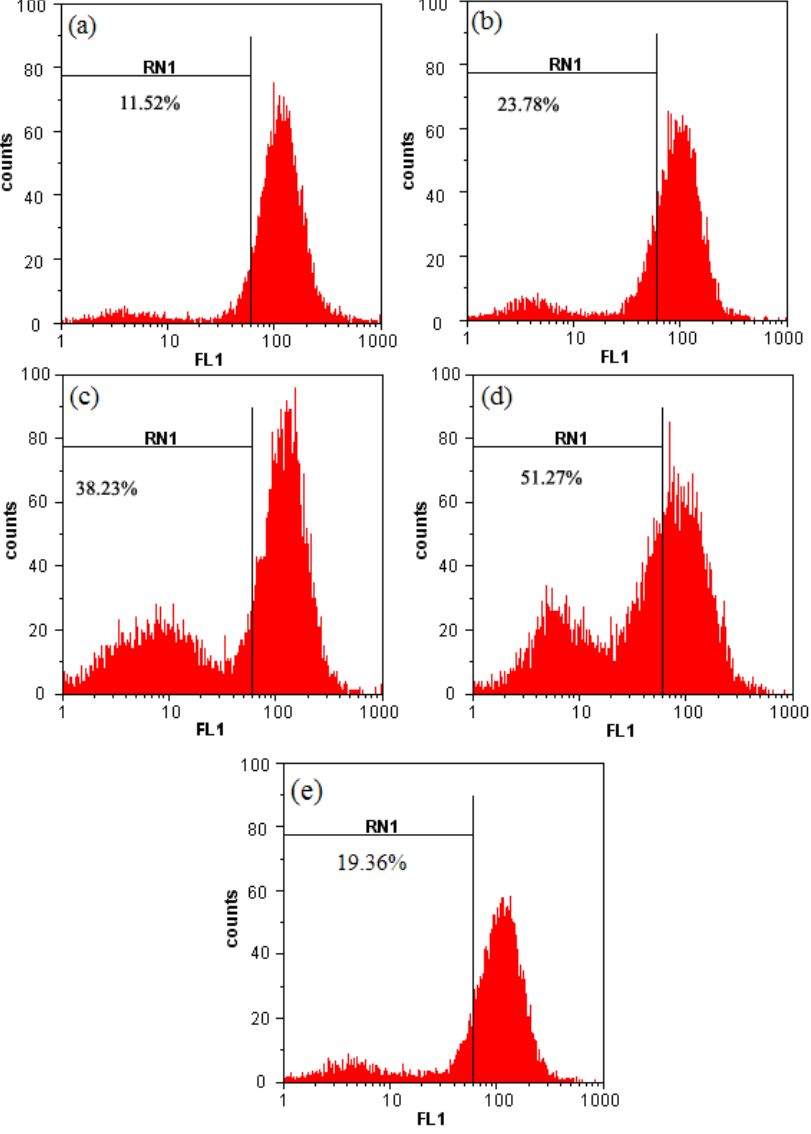
Figure 6. Mitochondrial membrane potential of A549 cells after treatment with chamaejasmine using Rh123 staining. ( a )-( d ) Treatment with 0, 2, 4 and 8 µM chamaejasmine, respectively; ( e ). Treatment with 5 mM NAC and 8 µM chamaejasmine; These figures are one representative experiment of three with similar